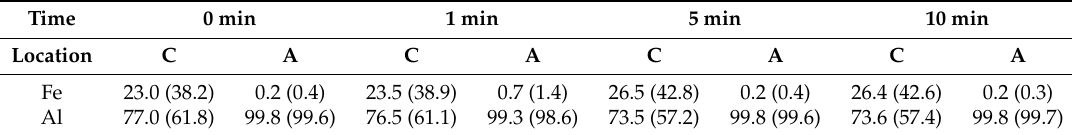
Figure 2. SEM-EDS analysis of our cast iron / liquid aluminum interface isothermally heated at 720 ◦ C for di ff erent times: ( a ) 0 min, ( b ) 1 min, ( c ) 5 min, ( d ) 10 min (C refers to the interfacial compound region and A refers to the aluminum base region near the interface in Table 2). Table 2. Concentrations (at.%) of intermetallic compounds (C) at the interface of cast iron / liquid aluminum and aluminum matrix (A) near the interface with respect to the holding time (the numbers in parenthesis indicate weight